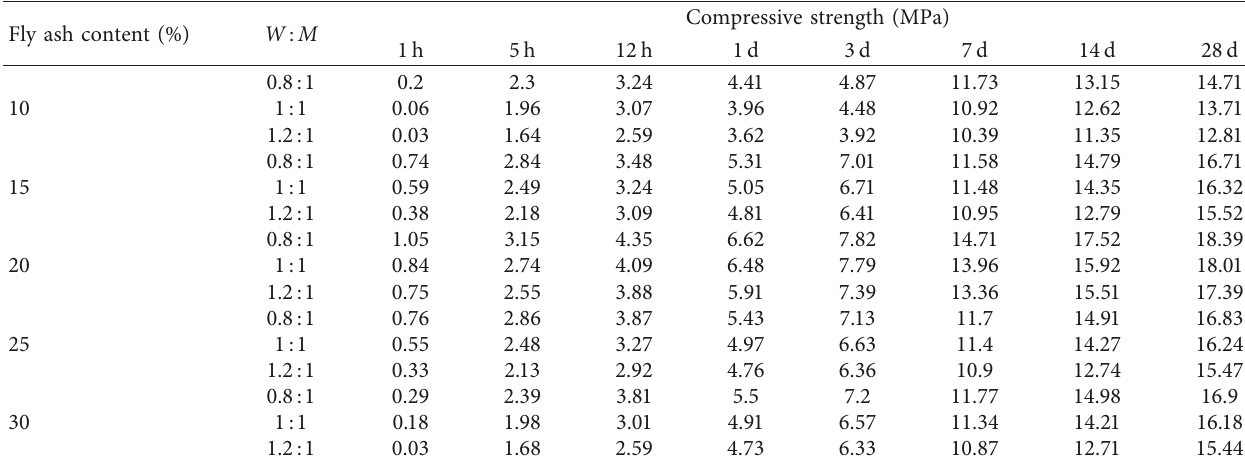
Figure 1: The curve of the initial and final settling time with fly ash content. Table 2: Compressive strengths under different